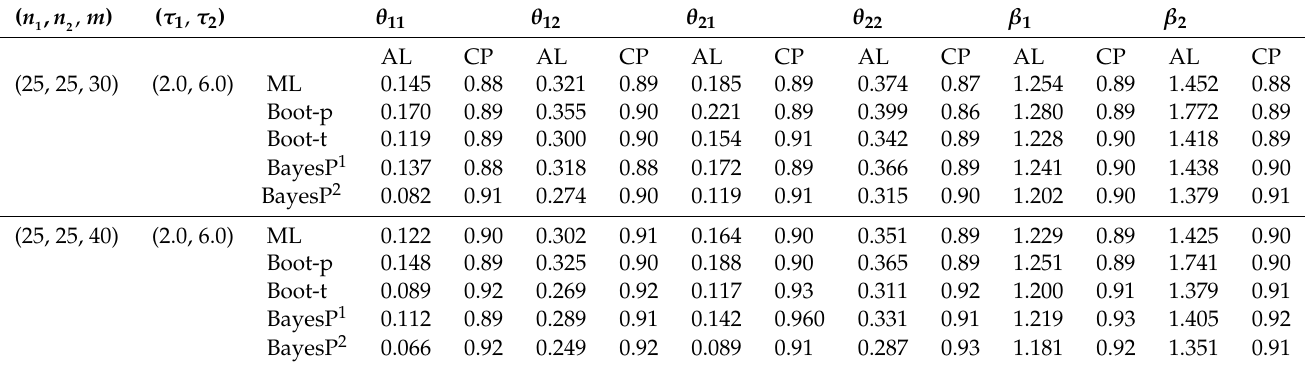
Table 2. AL and CP of the parameter estimates for the chosen Θ 1 = { 0.05,0.1,0.07,0.12,0.4,0.5 }